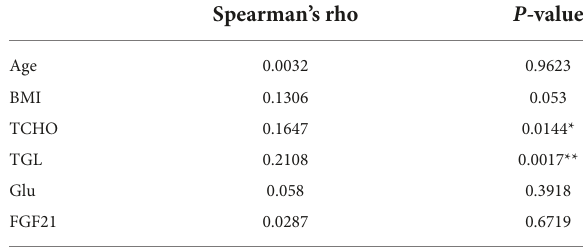
TABLE 3 Correlation of sACE2 and other factors in all the